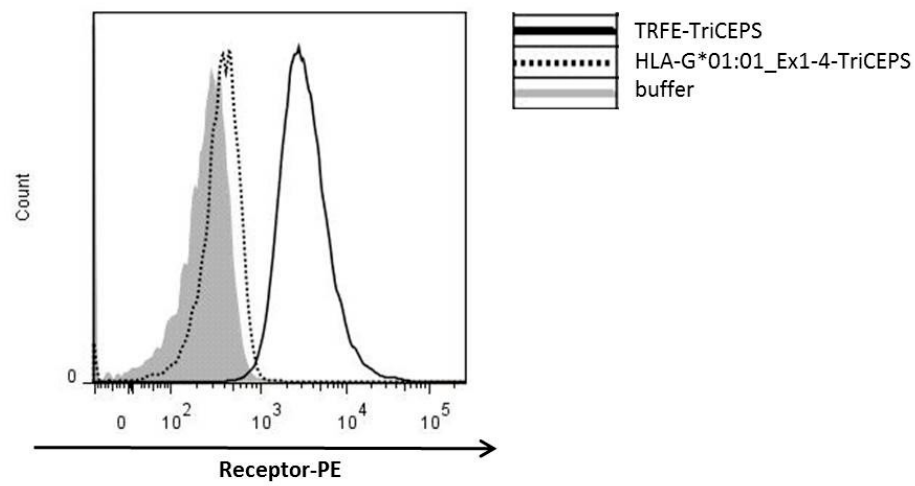
Figure A5. Binding of ligand- TriCEPS to NKL cells was successful. The positive control transferrin and the ligand of interest sHLA-G*01:04 were coupled to the TriCEPS molecule and incubated with the target cells. Via detection of the third domain of the TriCEPS molecule, a biotin domain, successful binding of the coupled ligands was observed using flow